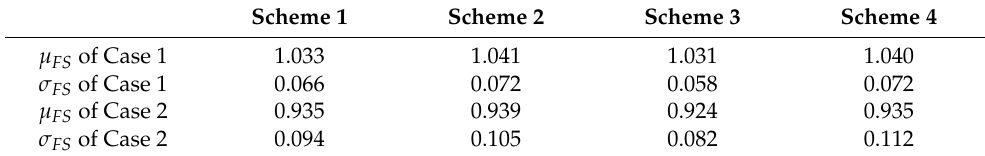
Table 2. The results of conditional MCS.